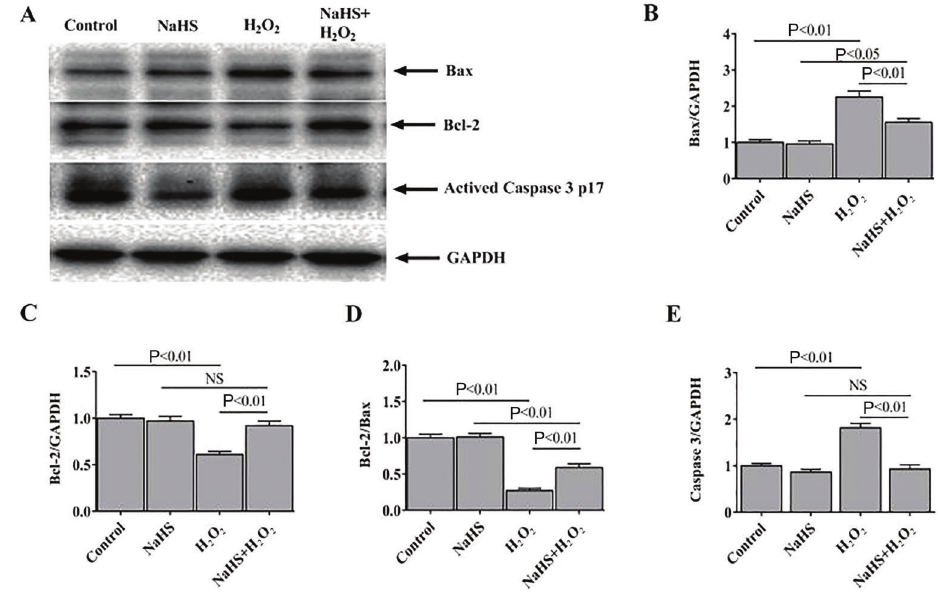
Figure 4. Hydrogen sul fi de (H 2 S) regulated the expression of apoptosis-related proteins. A , Representative immunoblots showing the expression of Bax, Bcl-2, and activated caspase 3 p17 in the H9c2 cells. Bax ( B ) and Bcl-2 ( C ) expression normalized to GAPDH (n=6). D , Densitometric analysis of the ratio of Bcl-2 to Bax. E , Activated caspase 3 p17 expression normalized to GAPDH. Data are reported as means ± SE (n=6) (ANOVA followed by Student-Newman-Keuls post hoc test). NS: not signi fi